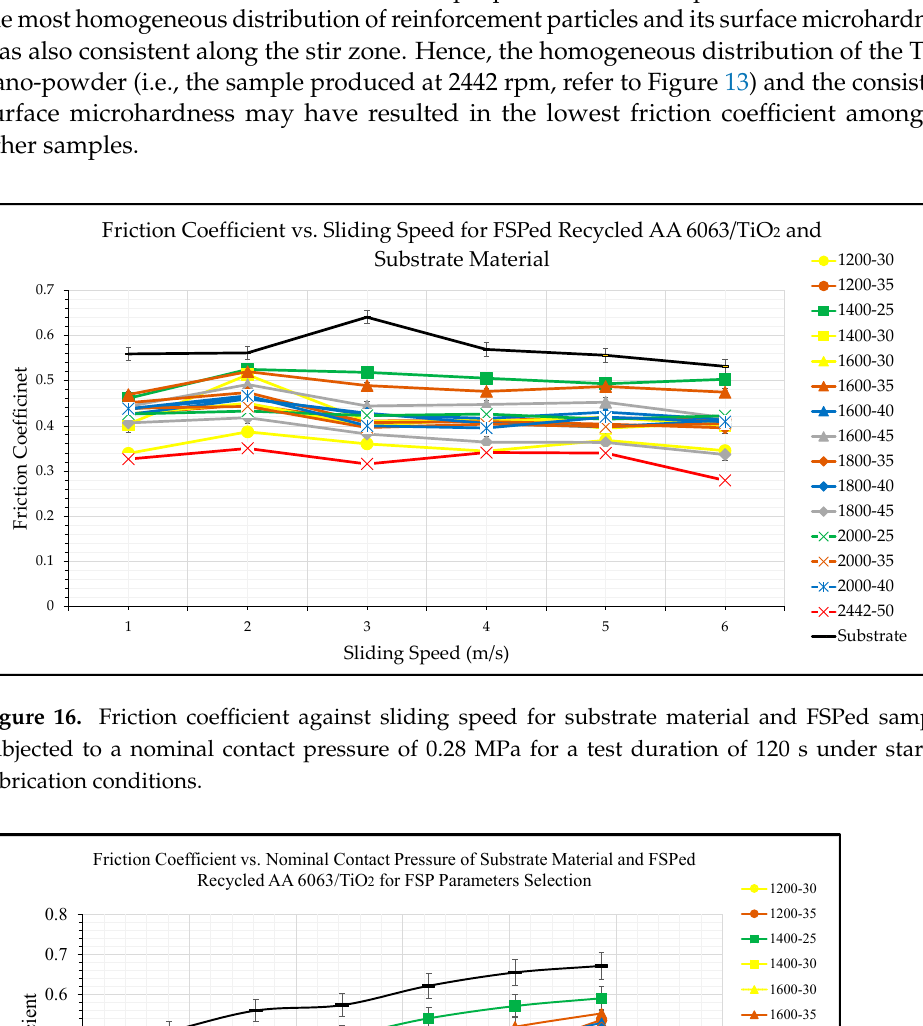
Friction Coefficient vs. Nominal Contact Pressure of Substrate Material and FSPed Recycled AA 6063/TiO 2 for FSP Parameters Selection